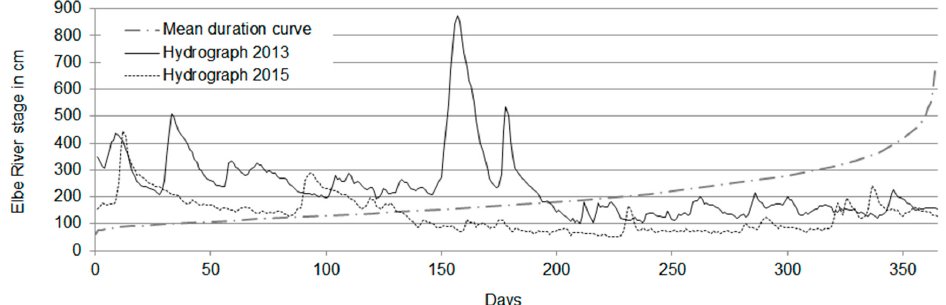
Figure 1. Elbe River flow conditions at Dresden (55.63 km; [5]).